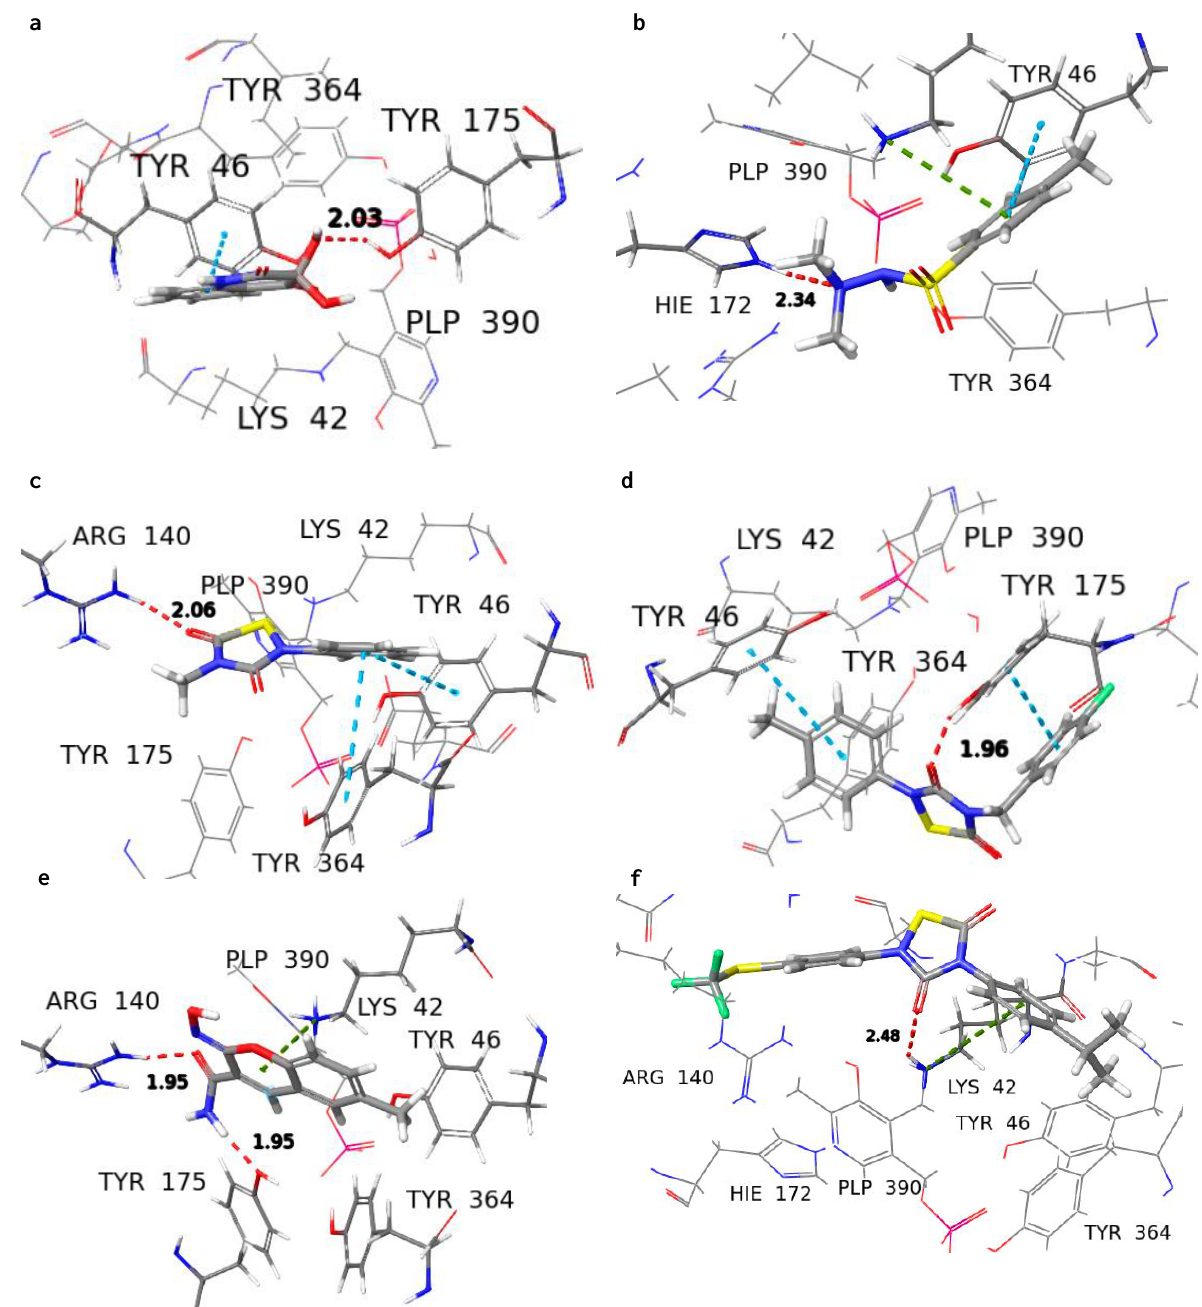
Figure S2. Binding mode of compounds (a) 1 , (b) 9 , (c) 12 , (d) 16 , (e) 22 and (f) 23 in the catalytic pocket of Mycobacterium tuberculosis AlaR enzyme (PDB ID: